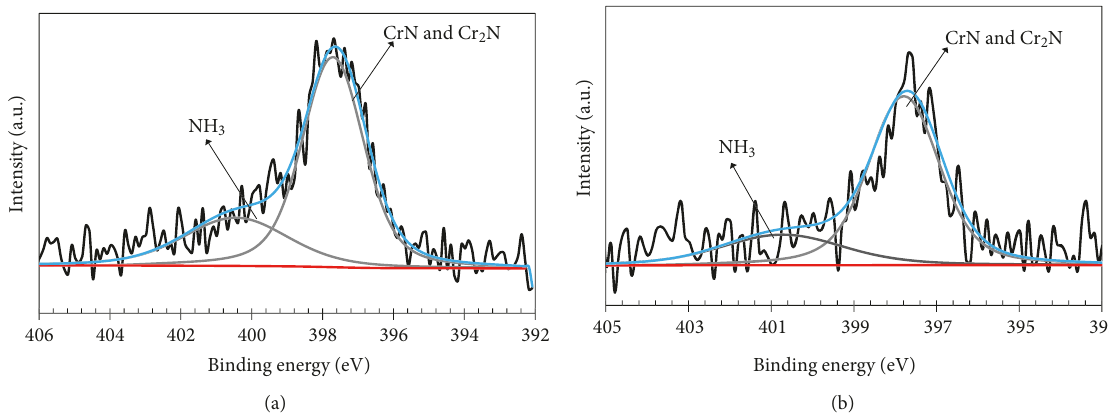
Figure 2: XPS spectra for the N1s core levels: (a) N and (b) NK